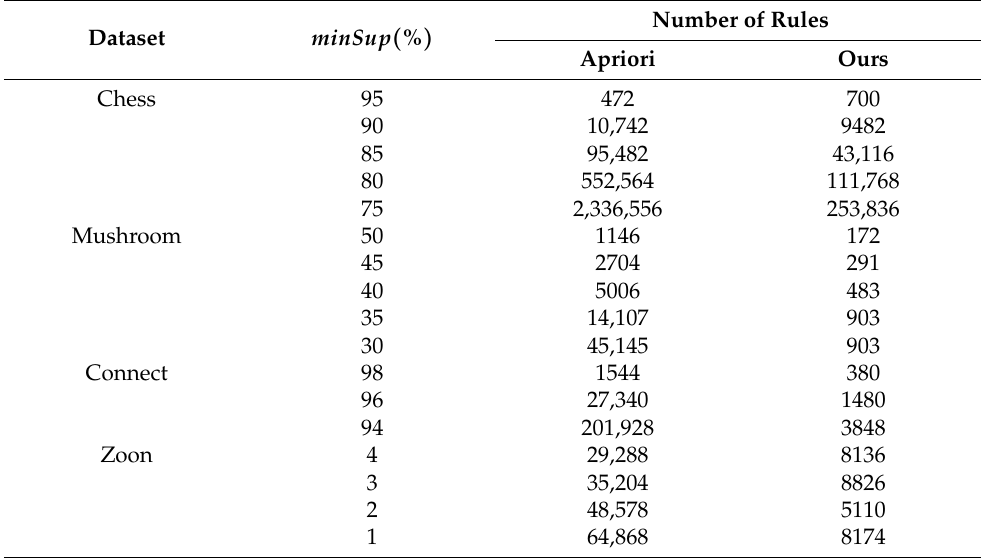
Table 10. Number of rules of Apriori and